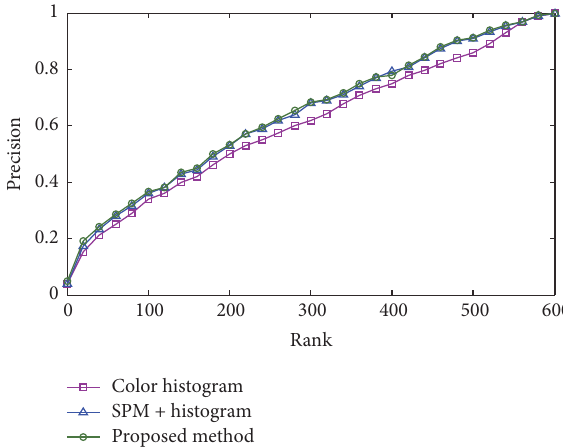
Figure 8: CMC curves on the VIPeR dataset for the proposed method and histogram methods in RGB space.